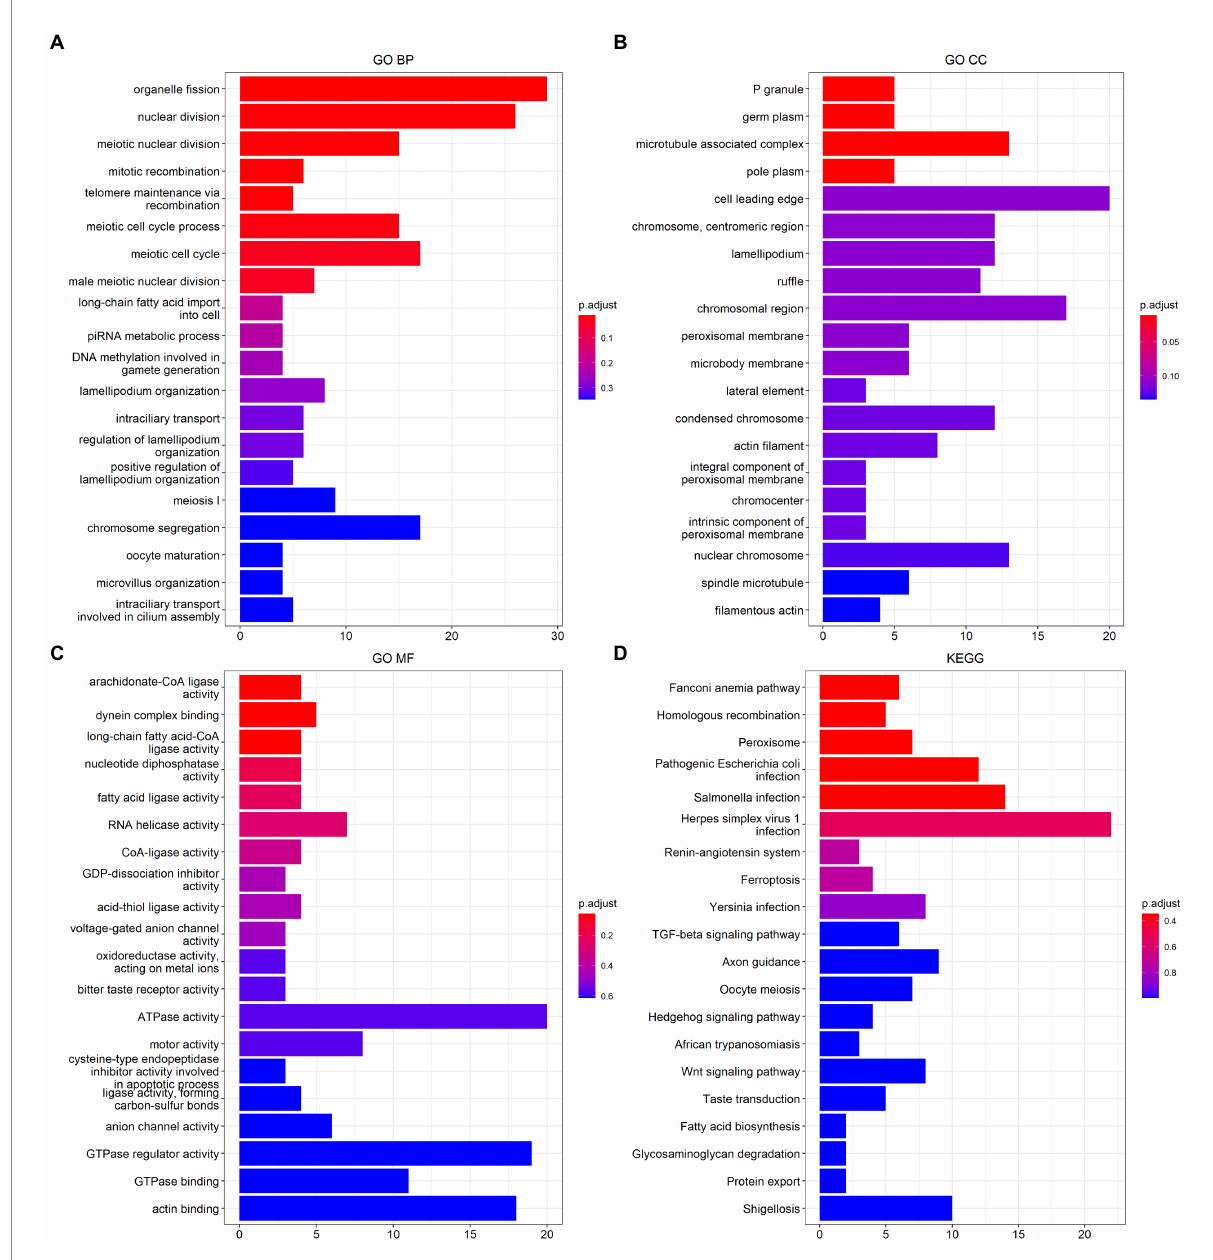
FIGURE 8 Function analysis of m6A modification classes-related differentially expressed genes in ischemic stroke. (A) BP of GO enrichment analysis. (B) CC of GO enrichment analysis. (C) MF of GO enrichment analysis. (D) KEGG pathway enrichment analysis. BP, biological process. CC, cellular component. MF, molecular function. GO, Gene Ontology. KEGG, Kyoto Encyclopedia of Genes and